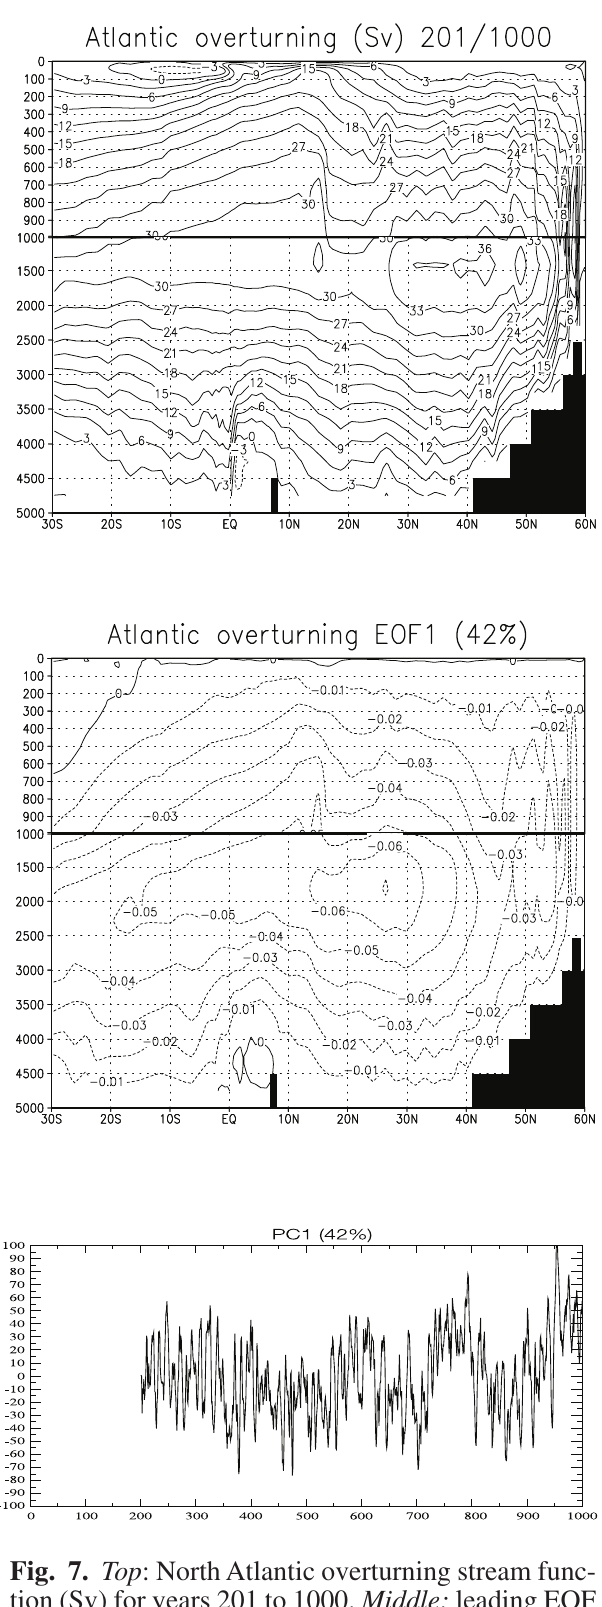
Fig. 7. Top : North Atlantic overturning stream func- tion (Sv) for years 201 to 1000. Middle: leading EOF structure. Bottom : corresponding time series. The mid- dle and bottom panels have arbitrary